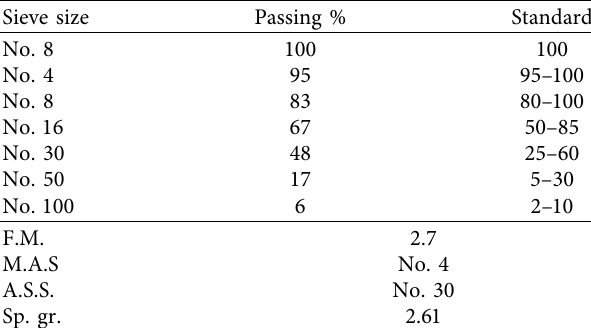
Table 3: Specification of used sand